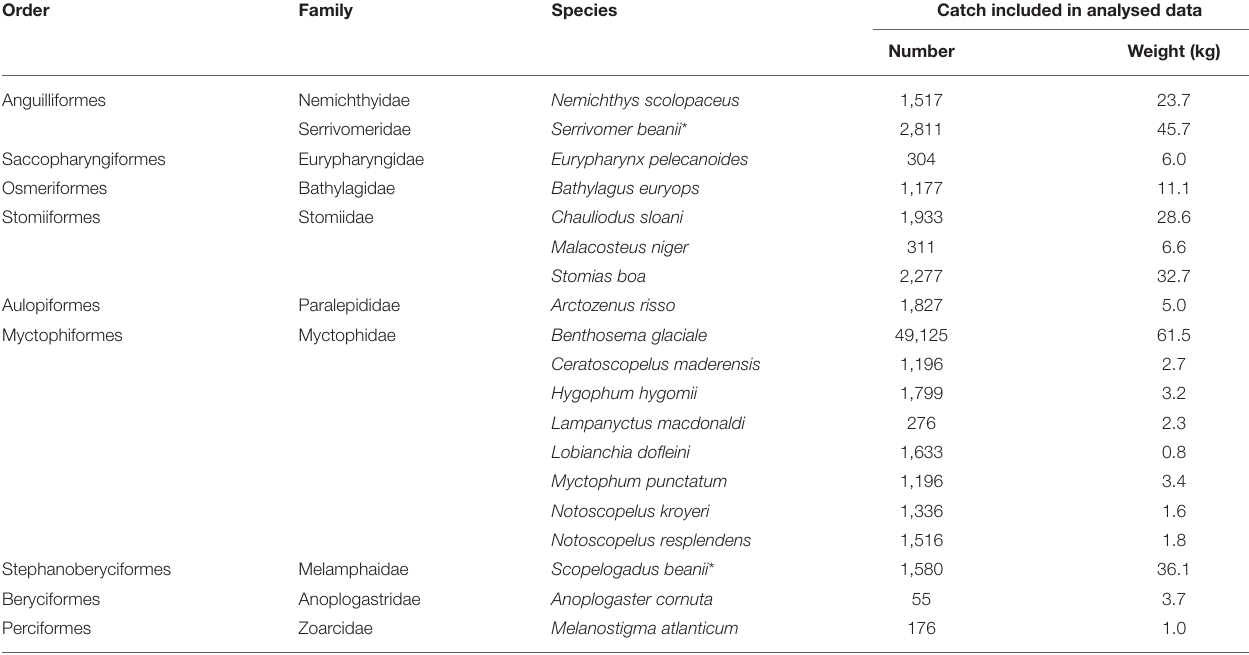
TABLE 2 | Species included in the